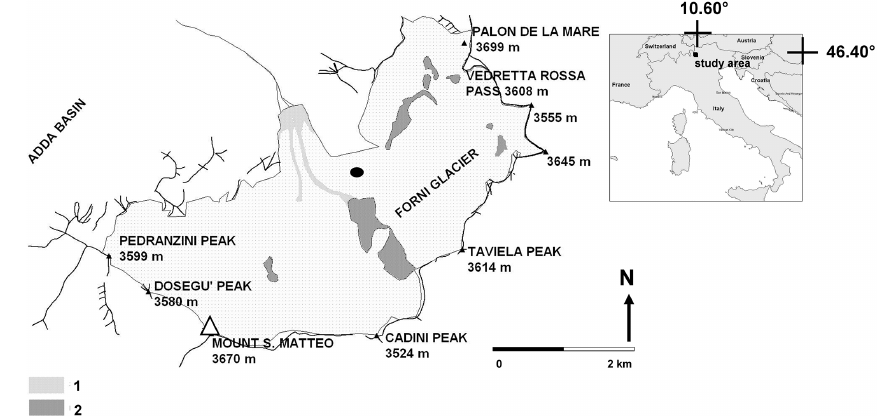
Figure 1. The location of the Forni Glacier and the AWS1 Forni (black dot, WGS84 coordinates: 46 ◦ 23 0 56.0 00 N, 10 ◦ 35 0 25.2 00 E, geodetic elevation: 2631ma.s.l.). The light-grey areas (1) are used to mark supraglacial debris coverage and the dark-grey areas (2) indicate rock exposures and